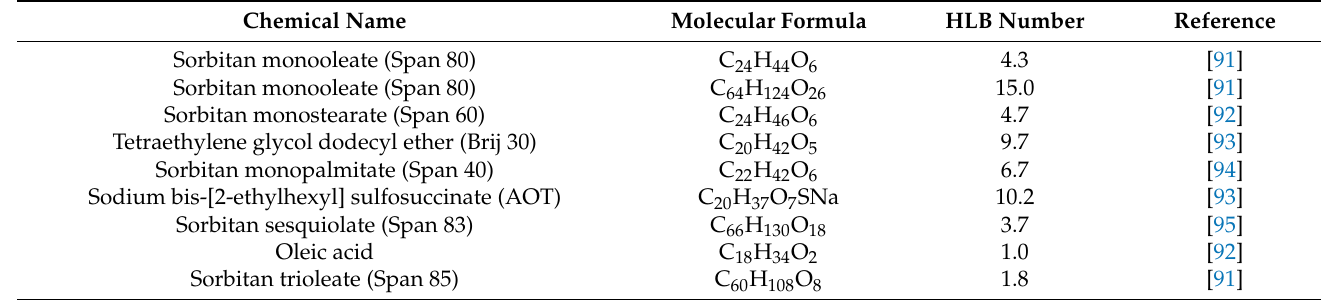
Table 2. Type of surfactants used in the preparation of emulsified biofuel.